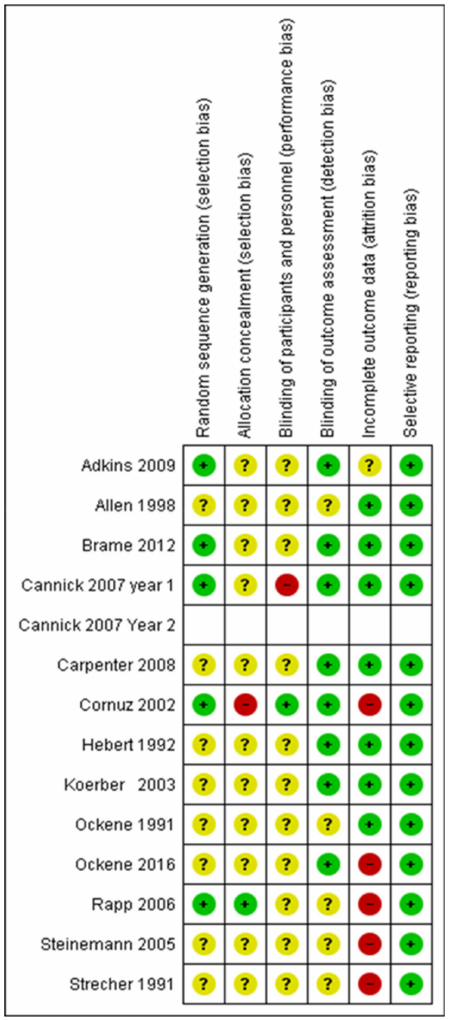
Figure 3. Risk-of-bias summary for meta-analysis articles. Note: To avoid double-counting the risk-of-bias in the assessment for Cannick et al. [76], Year 2 students is left blank. The risk of bias is a summary for both